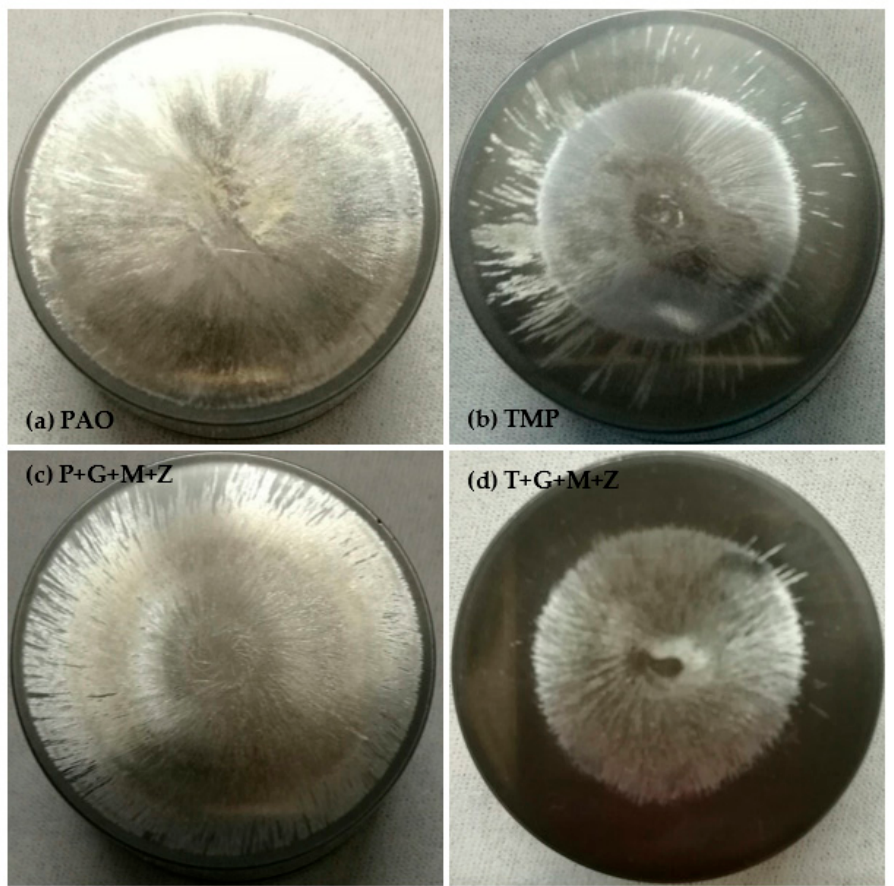
Figure 17. Optical images of a-C:H:W-coated tappets after cylinder head testing in combination with a-C:H:W-coated camlobes under various conditions in the presence of TMP-based and PAO-based lubricants.